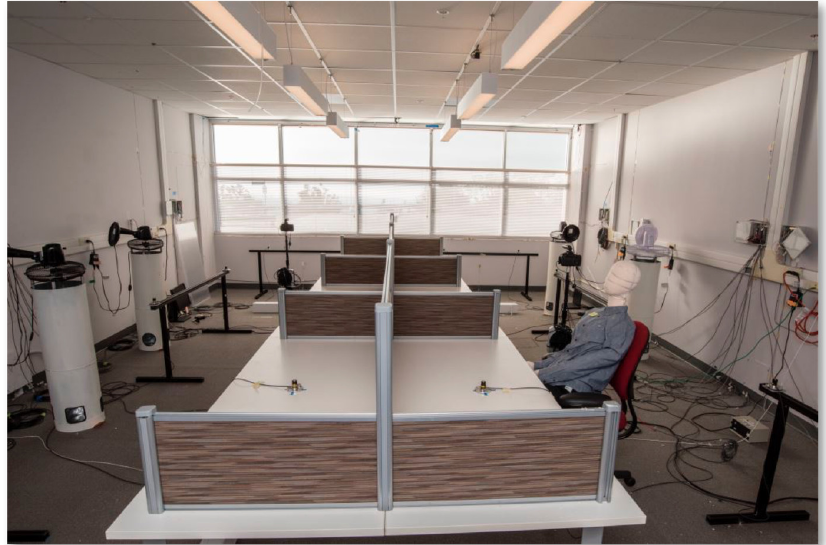
Figure 8. Photograph of Test System 3 setup in the lab. The workstation-specific lighting design is visible, with daylight responsive LED pendants located over each workstation.